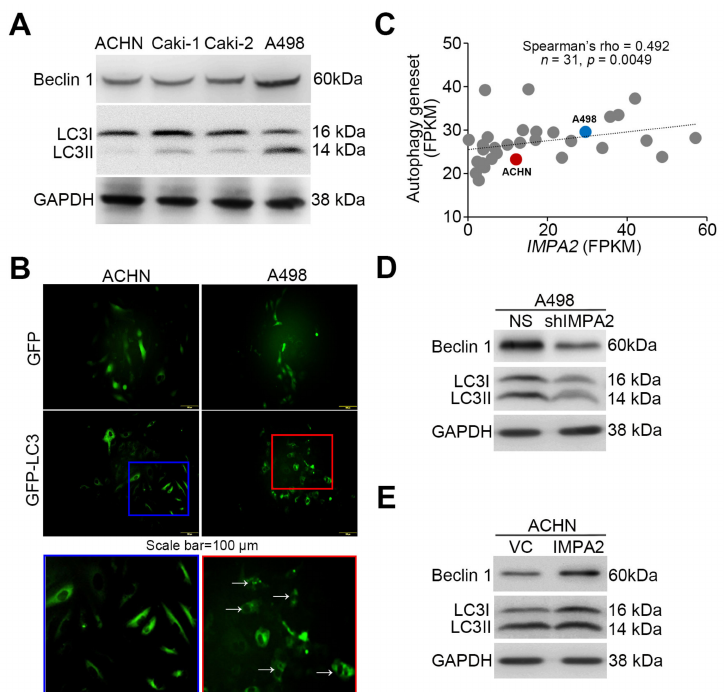
Figure 3. IMPA2 expression modulates autophagy initiation in ccRCC cells. ( A ) Western blot analyses for Beclin 1, LC3I / II and GAPDH proteins in whole cell lysates derived from the tested ccRCC cell lines. ( B ) The fluorescent microscopic observation of ACHN and A498 cells that were stably transfected with gene encoding GFP or GFP-LC3 fusion protein. Two representative pictures captured from GFP-LC3-expressing ACHN (blue region) and A498 (red region) cells were employed to highlight the punctate distribution (white arrows) of autophagosomes in A498, not ACHN, cells. Scale bars in yellow represent 100 µ m. ( C ) Correlation of transcriptional profiling between IMPA2 and autophagy gene set in a panel of RCC cell lines from Cancer Cell Line Encyclopedia database. Spearman’s correlation test was used to estimate the statistical significance. ( D and E ) Western blot analyses for Beclin 1, LC3I / II and GAPDH proteins in whole cell lysates derived from A498 cells without (non-silencing, NS) or with IMPA2 knockdown ( D ), and ACHN cells without (vector control, VC) or with IMPA2 overexpression ( E ). In A , D , E , GAPDH was used as an internal control of protein